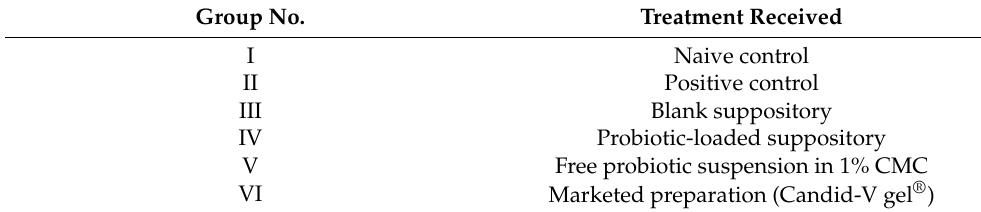
Table 6. Various groups planned in the study ( n = 3). Group